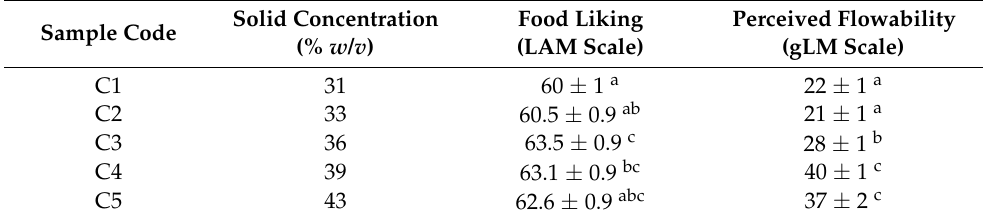
Table 2. Food liking and perceived flowability scores (mean value ± standard error) given by 176 subjects.